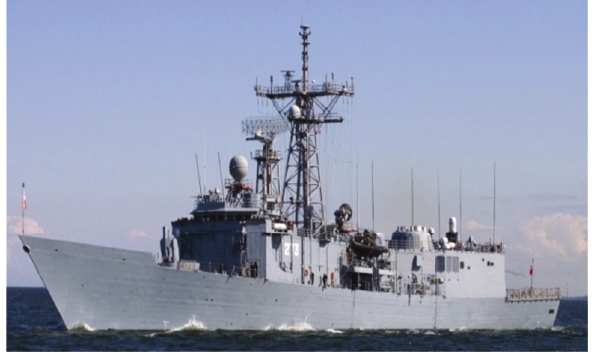
Fig. 1. FFG-7 class ship